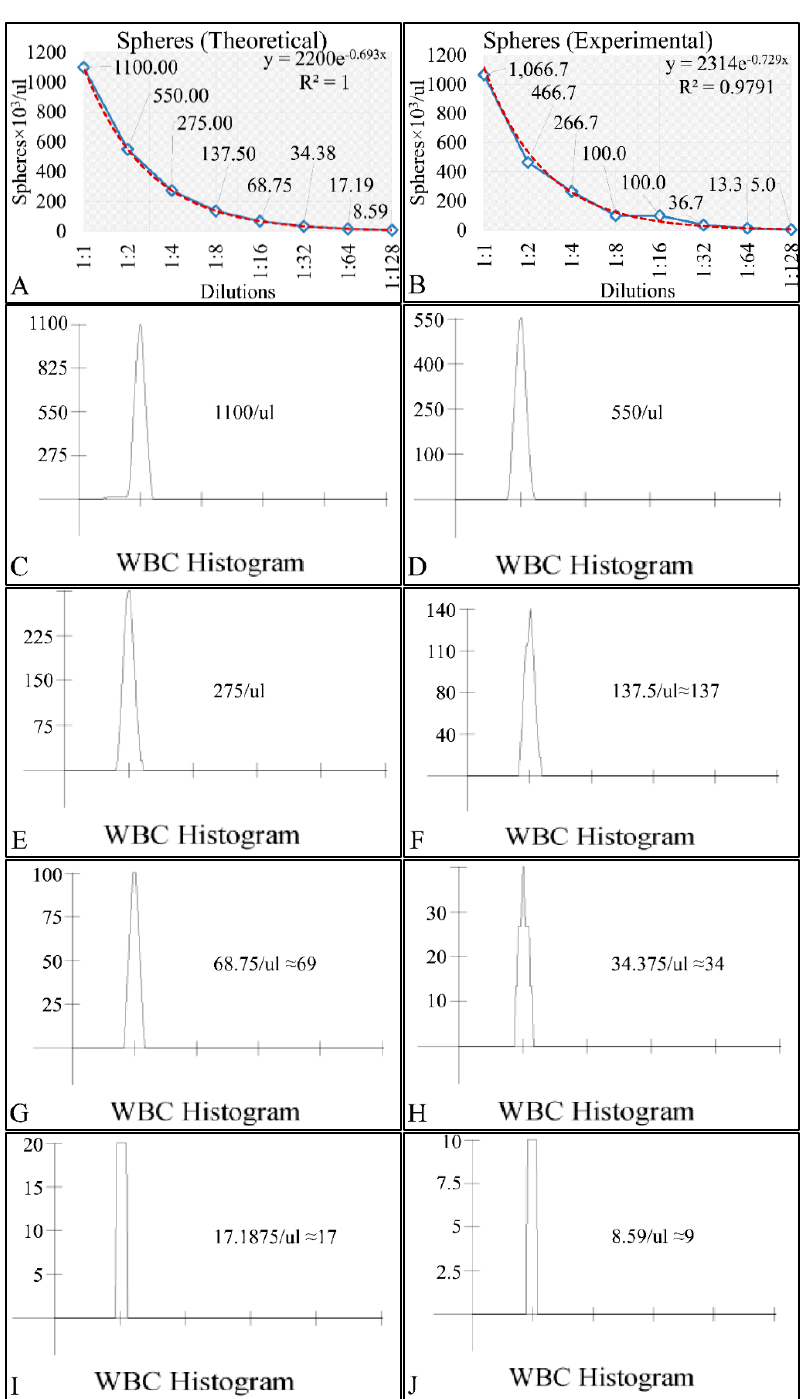
Figure 2 . The calibration measurements with the Coulter counter, investigating the sensitivity of the instrument. In particular, the theoretical ( A ) and experimental ( B ) regressions of the dilution series are presented. Further on, the actual coulter-counter measurements are presented for sphere concentrations of 1100 spheres/ μ L ( C ), 550 spheres/ μ L ( D ), 275 spheres/ μ L ( E ), 137 spheres/ μ L ( F ), 69 spheres/ μ L ( G ), 34 spheres/ μ L ( H ), 17 spheres/ μ L ( I ) and 9 spheres/ μ L ( J ).